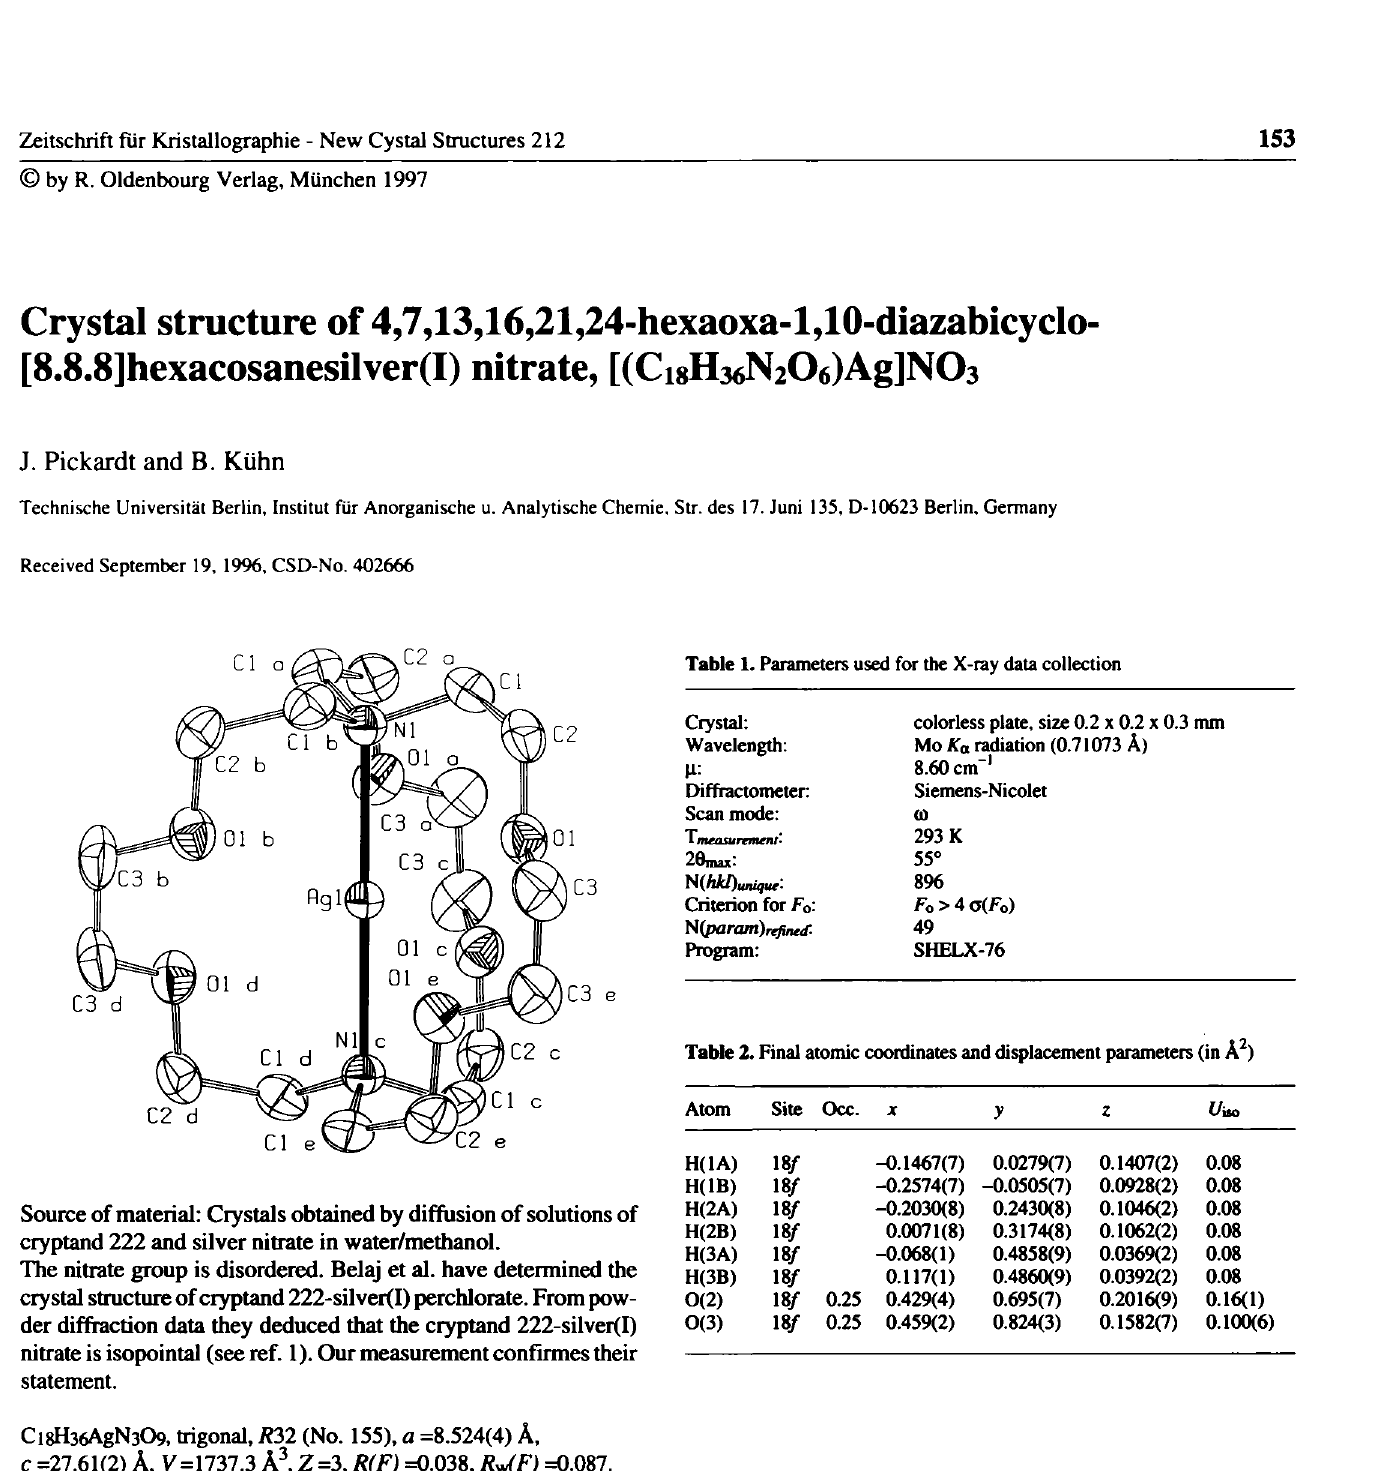
Table 3. Final atomic coordinates and displacement parameters (in Â 2 ) Atom